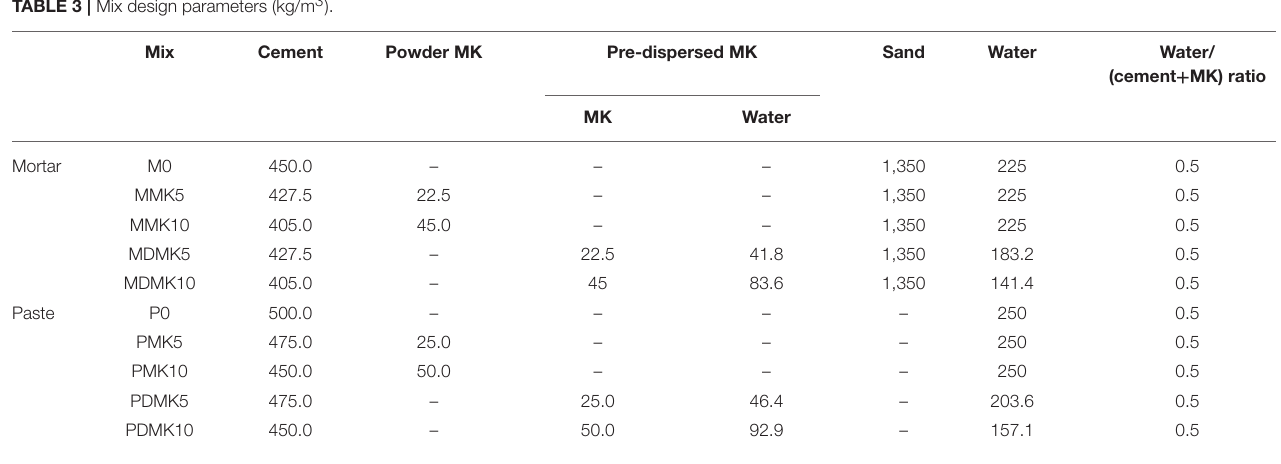
TABLE 3 | Mix design parameters (kg/m 3